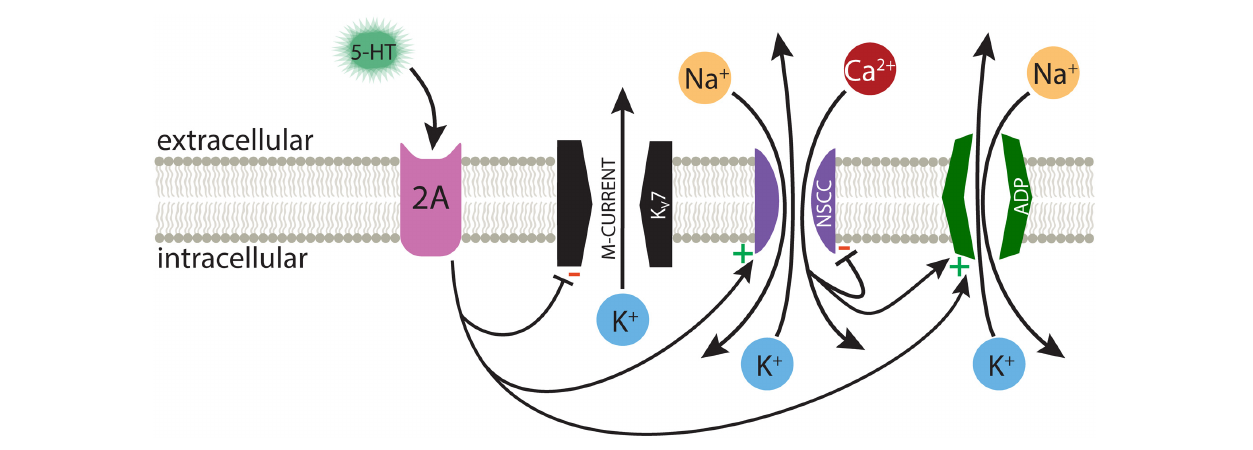
FIGURE 8 | Ionic effectors contributing to serotonergic excitation of COM neurons. Activation of G q -coupled 5-HT 2A receptors in COM neurons targets a range of ionic effectors, including suppression of M-current, calcium-dependent activation of the ADP current, and activation of a calcium-sensitive, but calcium-permeable, non-specific cation conductance